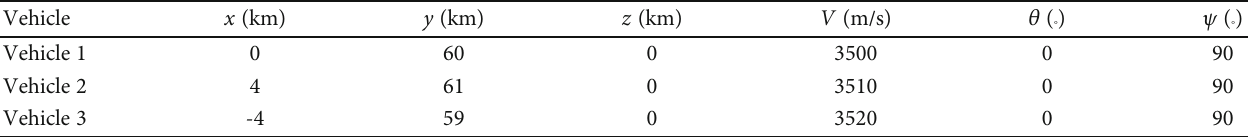
Table 1: The initial states of three